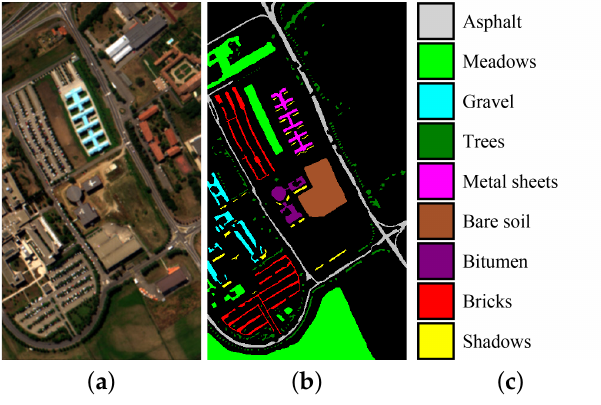
Figure 3. University of Pavia data set. ( a ) false-color composite; ( b, c ) ground truth